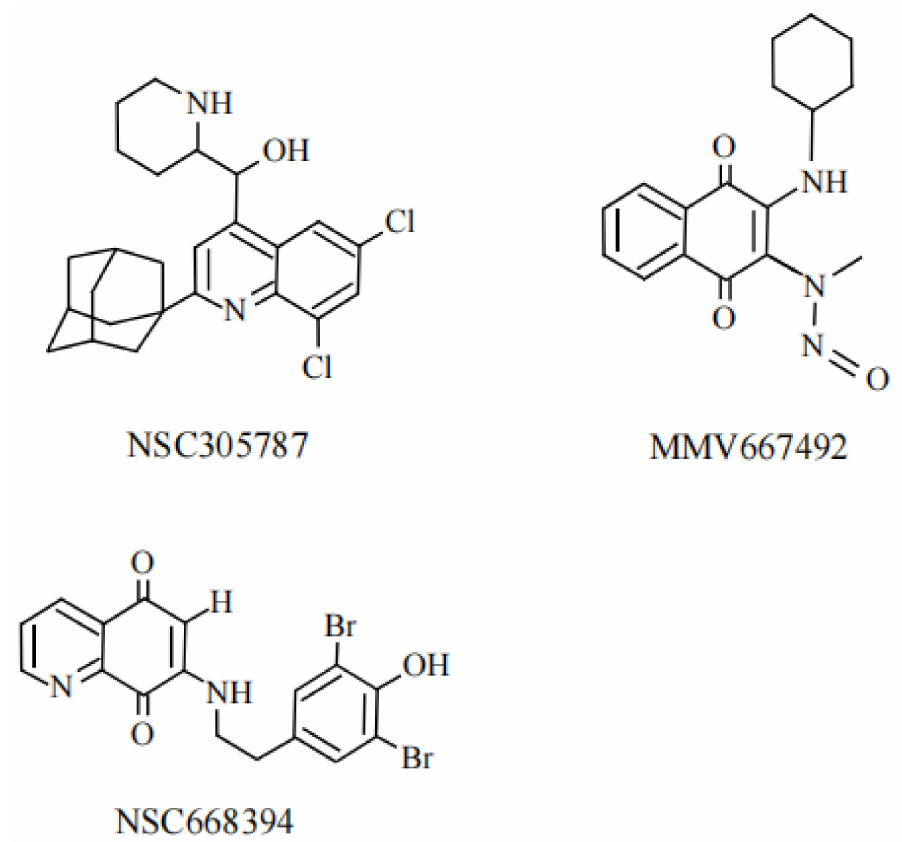
Figure 10. The chemical structures of ezrin inhibitors, NSC305787, NSC668394, and